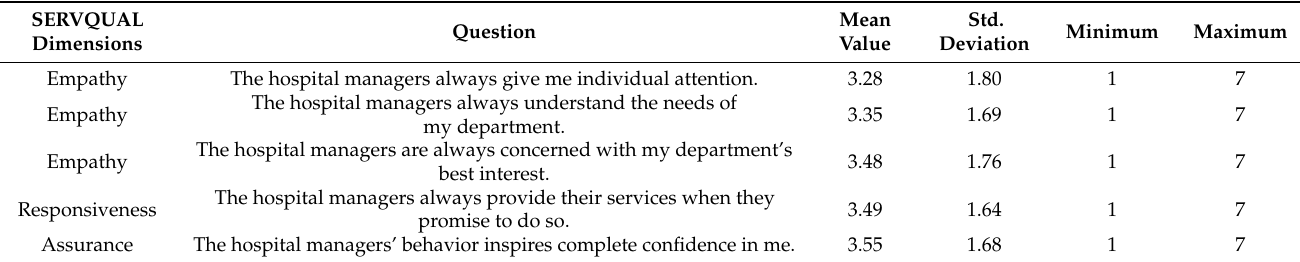
Table 5. The five (5) questions with the lowest